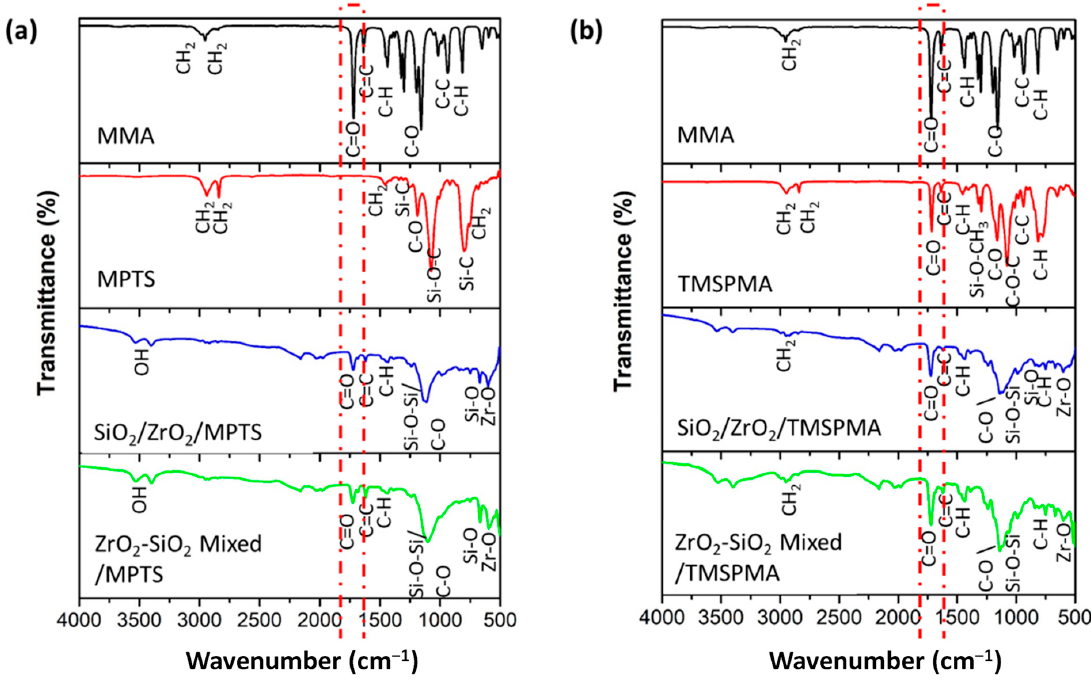
Commented [MZ3]: Please add explanations for the solid, hollow circles, Hollow squares and solid squares